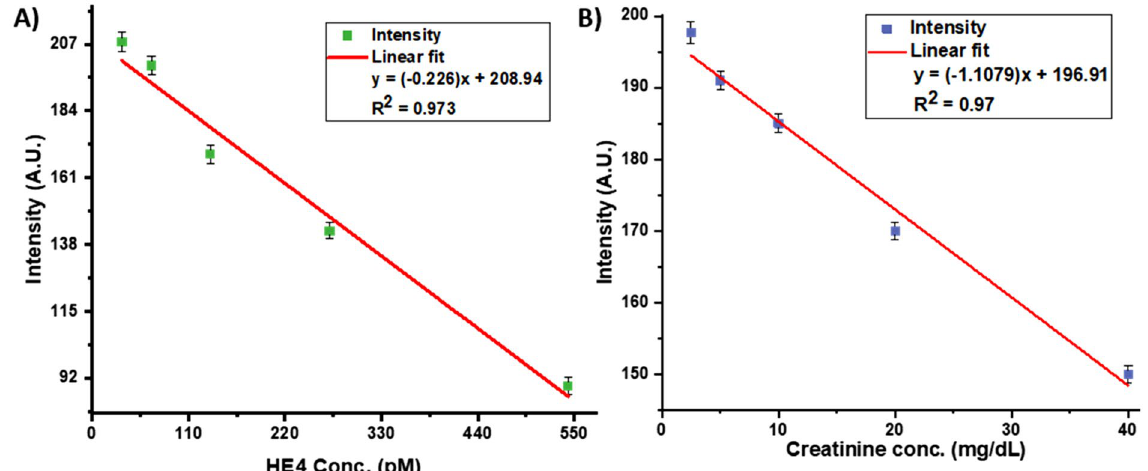
Figure 8. Calibration plots generated from the cell phone-based device. ( A ) Standard curve for concentrations of HE4 (pM) (mean + s.d, n = 2). ( B ) Standard curve for concentrations of creatinine (mg/dL) from cell phone (mean + s.d, n =